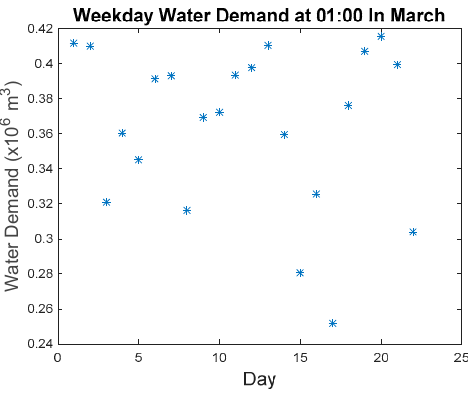
Figure 3. Normalized weekday and weekend water demand trend.